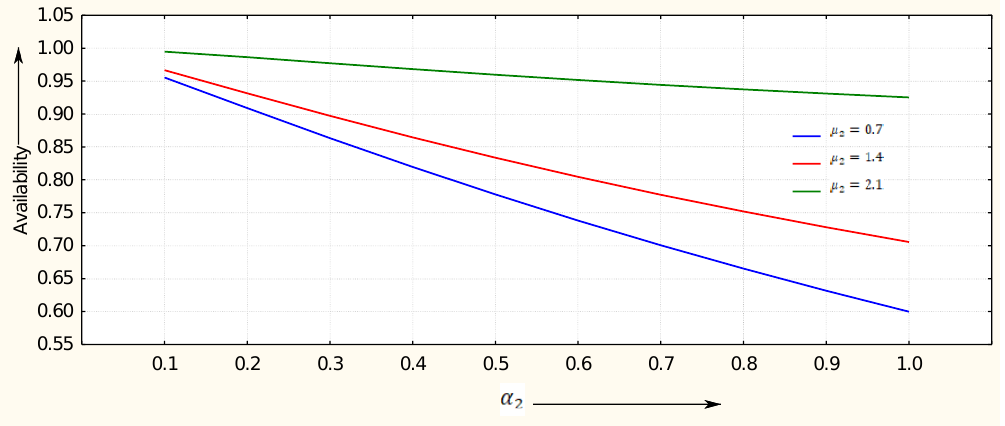
Figure 9. Behaviour of availability w.r.t. 𝛼